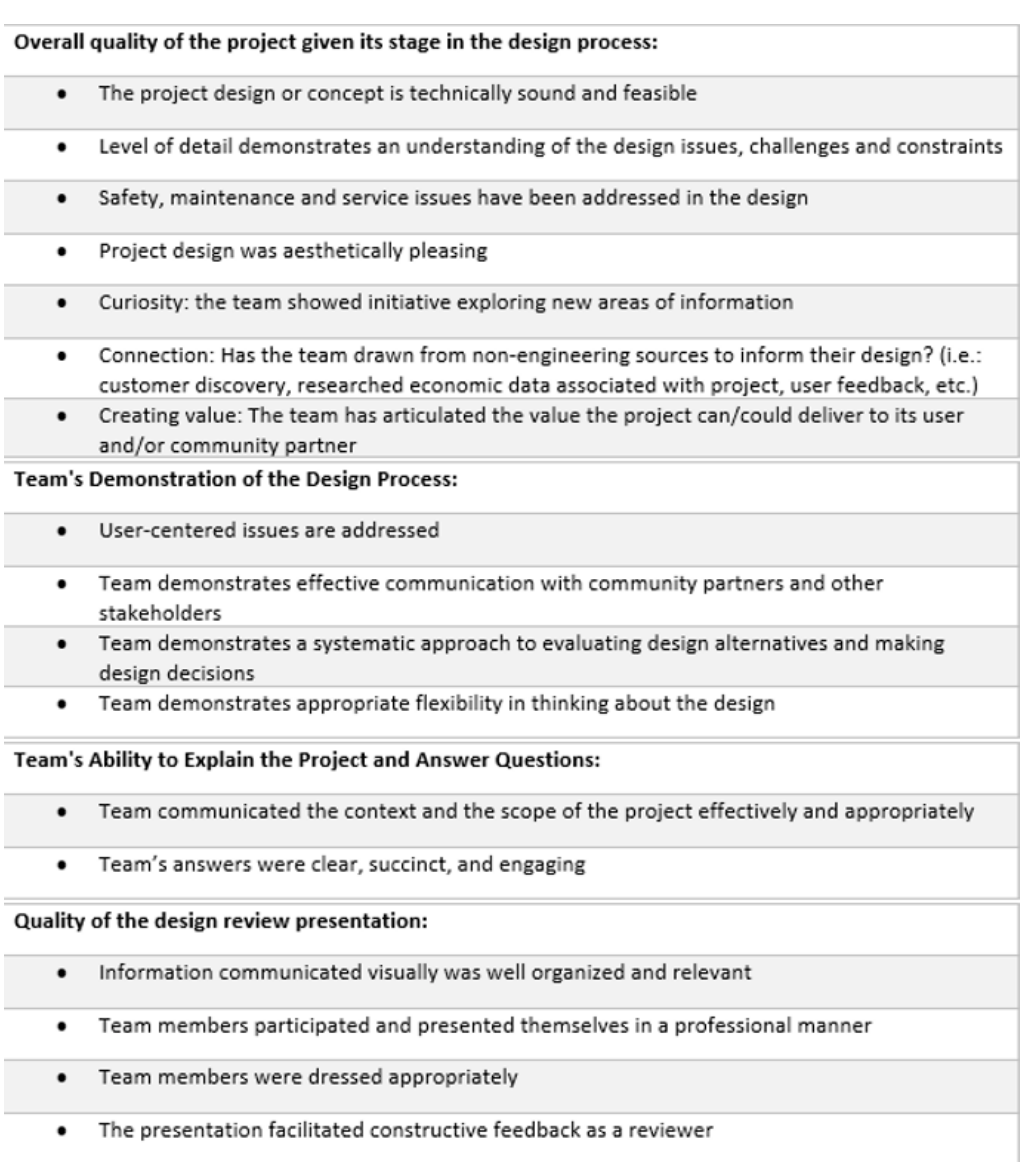
Figure 22. Students in EPICS Showcase lead by Dr Thinh and Dr Ha. Electronics 2019 , 8 , 200